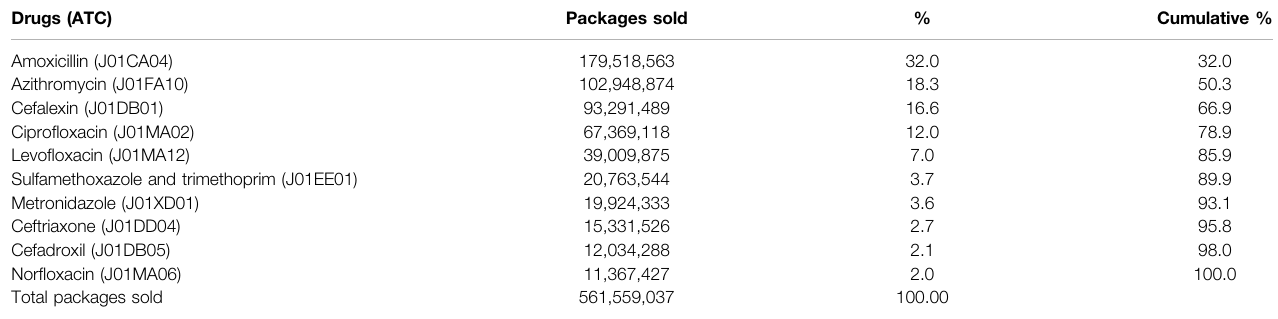
TABLE 1 | Top selling antibiotics in Brazil between January 2014 and July 2021 and their market share (%). Drugs (ATC)